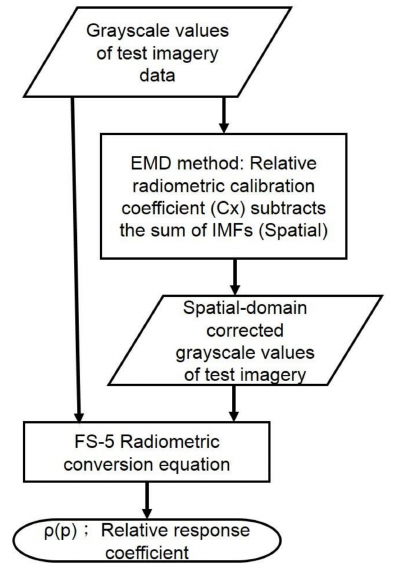
Figure 6. Flow chart of relative radiometric calibration in the spatial